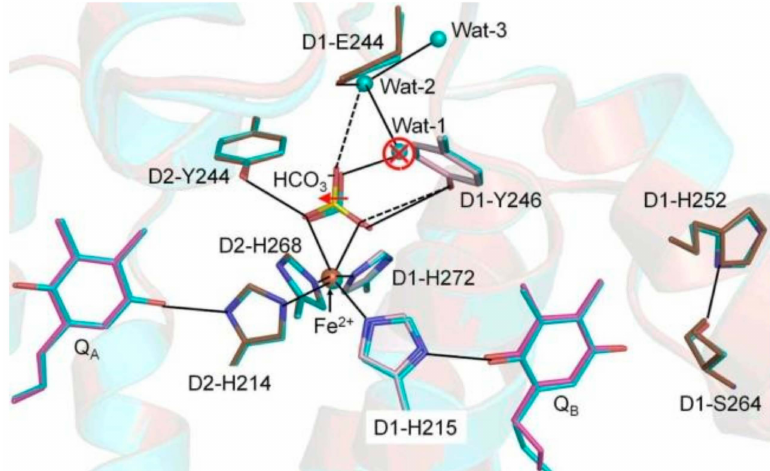
Figure 2. Superimposition of native Ca-PSII (PDB: 3WU2) and Sr-PSII (PDB: 4IL6) in the acceptor site pocket. The solid and dashed lines indicate that the hydrogen-bonding network within the acceptor site possibly facilitates the ET / proton transfer (PT) pathways that include two Q A , Q B , bicarbonate, non-heme iron (NHI), and water molecules. The red arrow and open circle indicate the major di ff erences between native Ca-PSII and